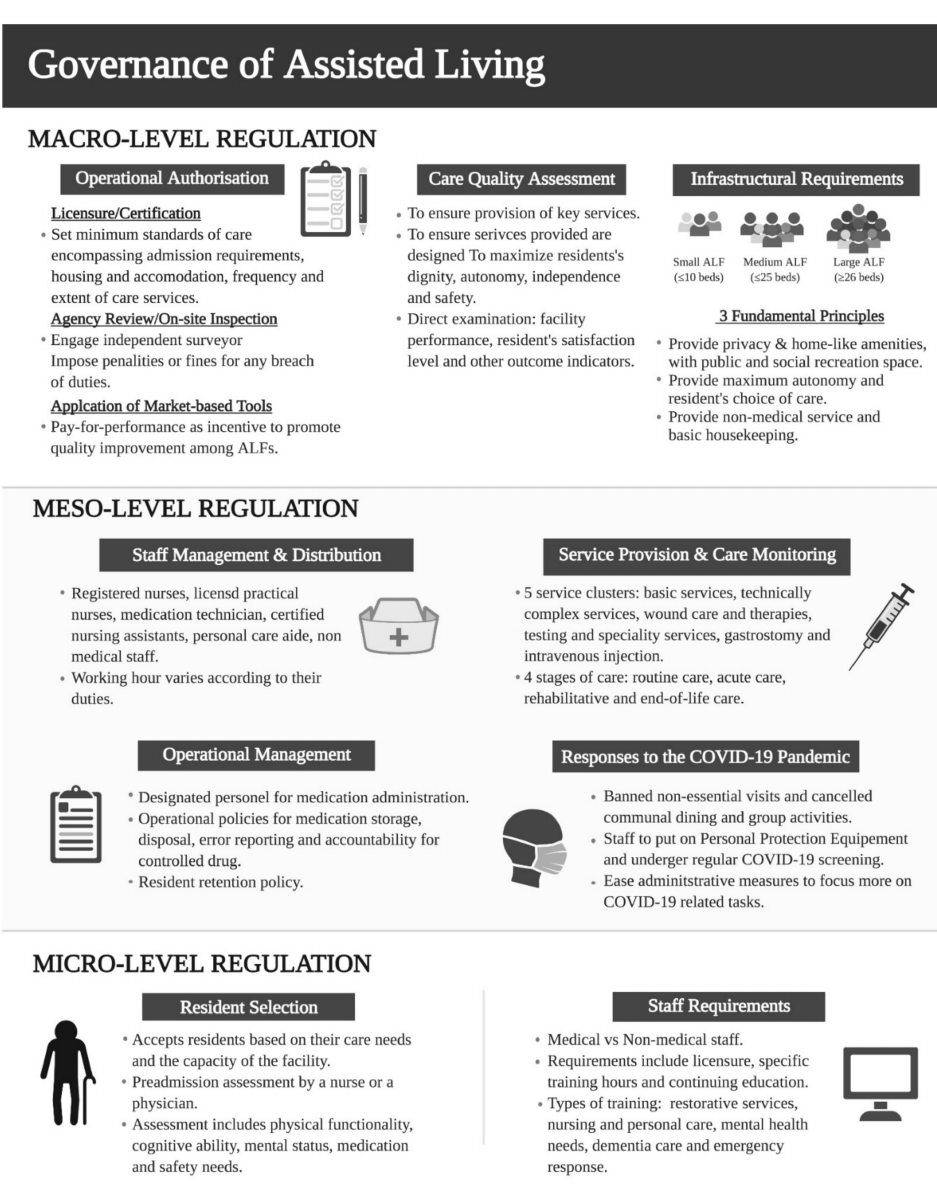
Figure 3. Summary of the macro-, meso- and micro-level regulations of AL consolidated from the